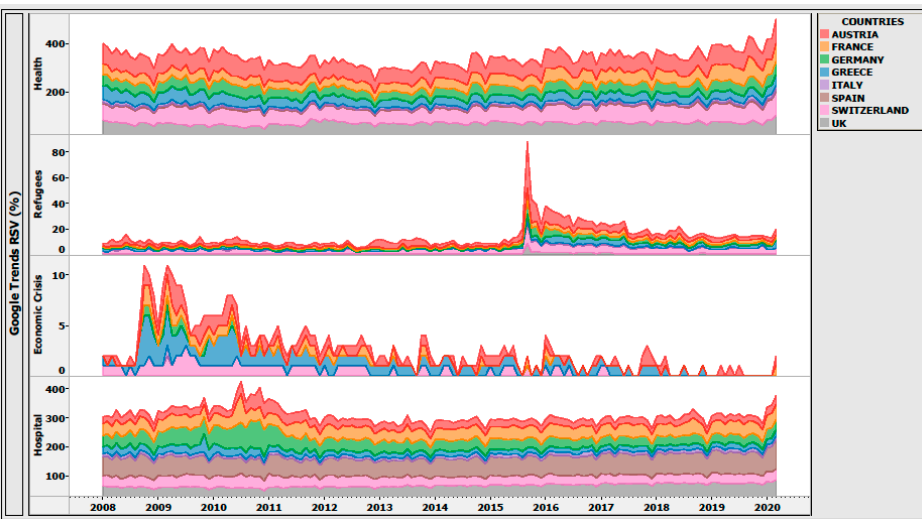
Figure 4. Comparison between relative search volume (RSV) trends of the Google searches for the keywords: “refugee”, “economic crisis”, “health”, and “hospital” between the eight most-affected European countries by the economic and refugee crises, January 2008–March 2020. The RSV volume is indicated by the thickness of each line graph. Note: Search volume data provided by Google Trends (https://www.google.com/trends) [4].